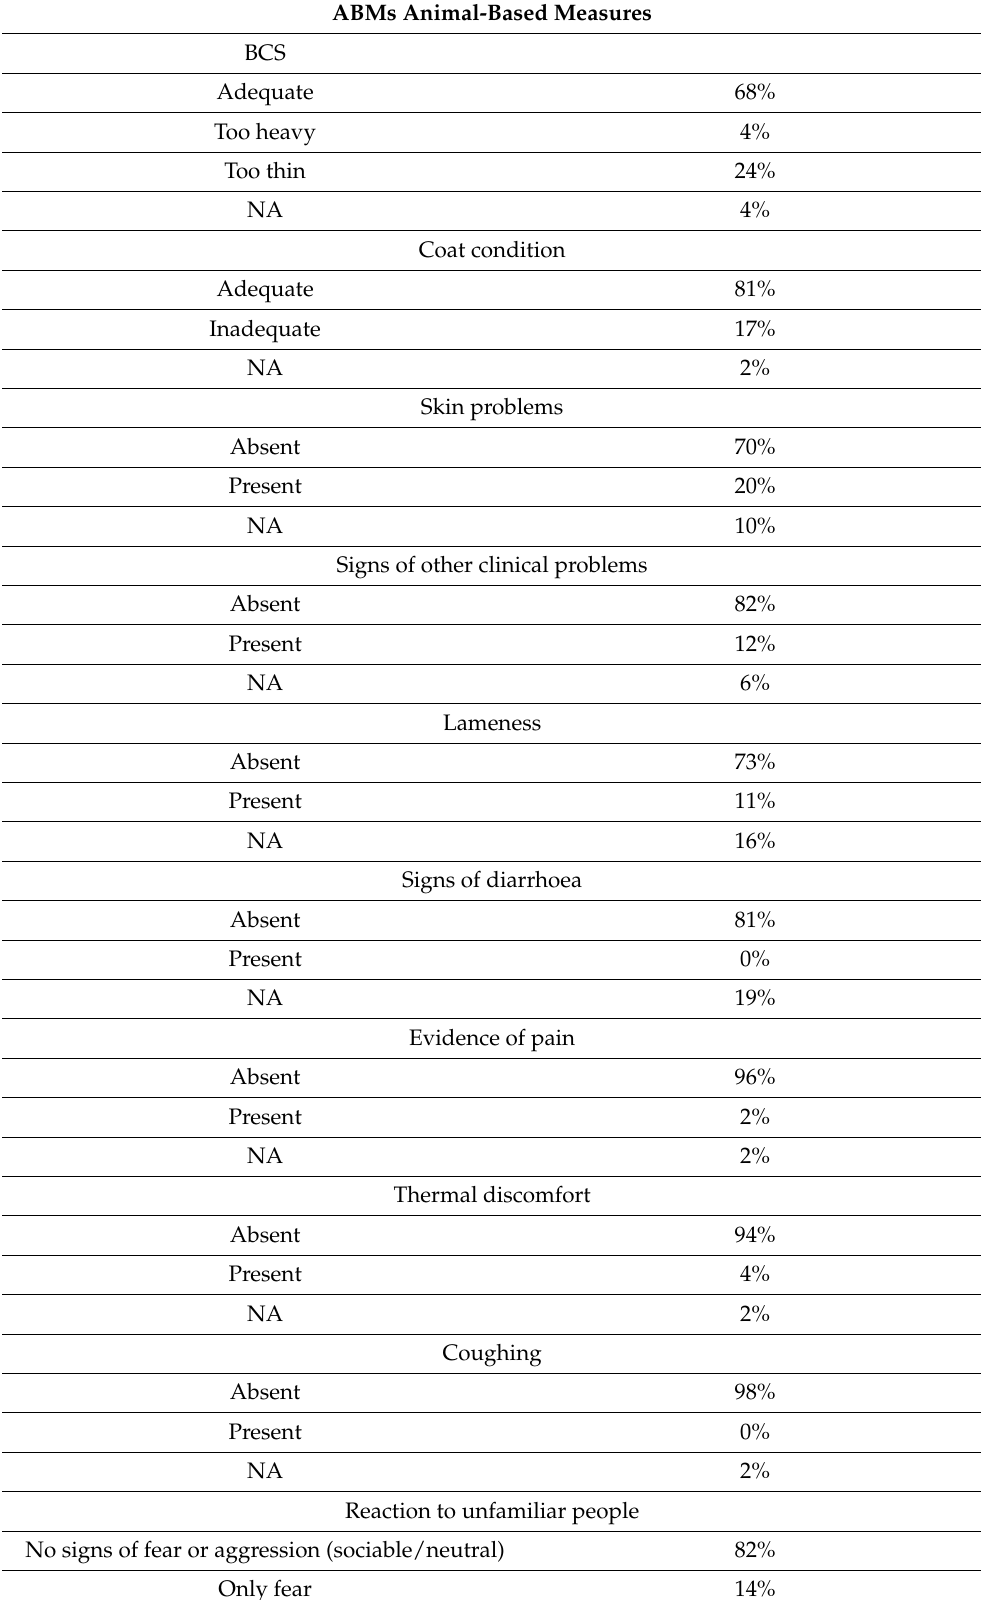
Table 3. Results of Animal-based measures assessment. The assessment follows the listed order. NA not